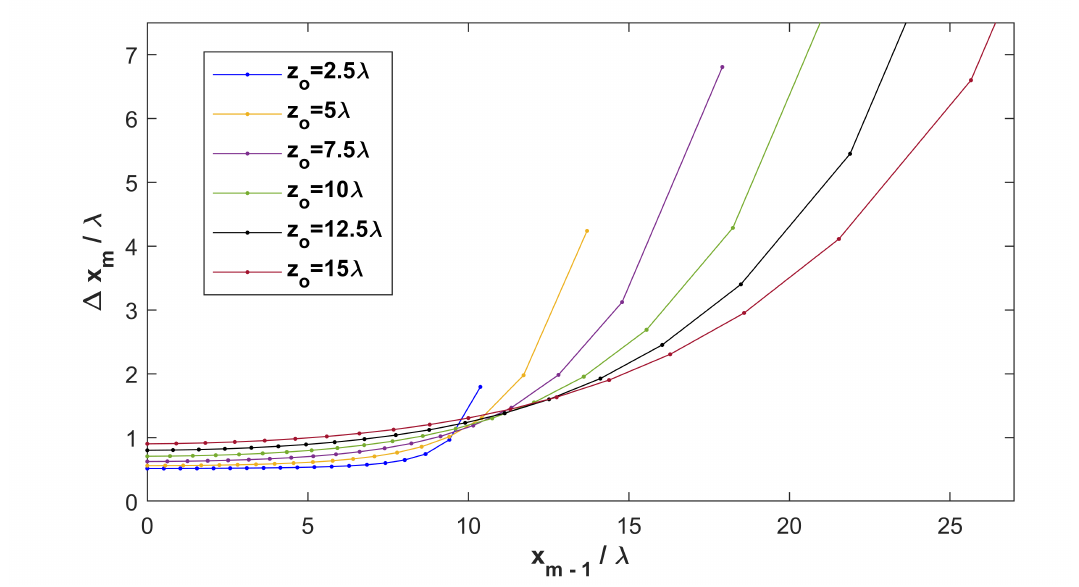
∆ x m in terms of x m − 1 for different values of z o in the case χ = λ